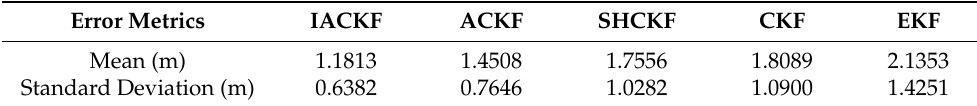
Table 5. Comparisons of the mean and standard deviation of different